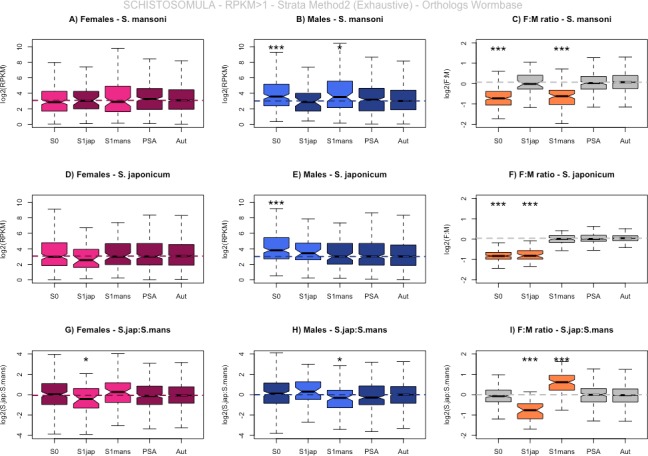
Schistosomula expression patterns (RPKM>1, exhaustive strata, Wormbase orthologs) of genes located in the different strata of the Z (S0, S1man and S1jap), as well as pseudoautosomal and autosomal genes.The distribution of expression values is shown for (A) S. mansoni females, (B) S. mansoni males, (C) S. mansoni female:male, (D) S. japonicum females, (E) S. japonicum males, (F) S. japonicum female:male, (G) Female expression in S. japonicum divided by female expression in S. mansoni, (H) Male expression in S. japonicum divided by male expression in S. mansoni, (I) female:male ratio of expression in S. japonicum divided by female:male ratio of expression in S. mansoni. Asterisks represent levels of significance of comparisons to the control autosomal genes (*p-value<0.05, **p-value<0.001, ***p-value<0.0001). Genes were assigned to each Z-chromosome stratum based only on their coverage patterns; only genes with RPKM >0 were used. This figure differs from Figure 2—figure supplement 8 as the Wormbase Parasite list 1:1 orthologs was used instead of our own reciprocal best hit results.